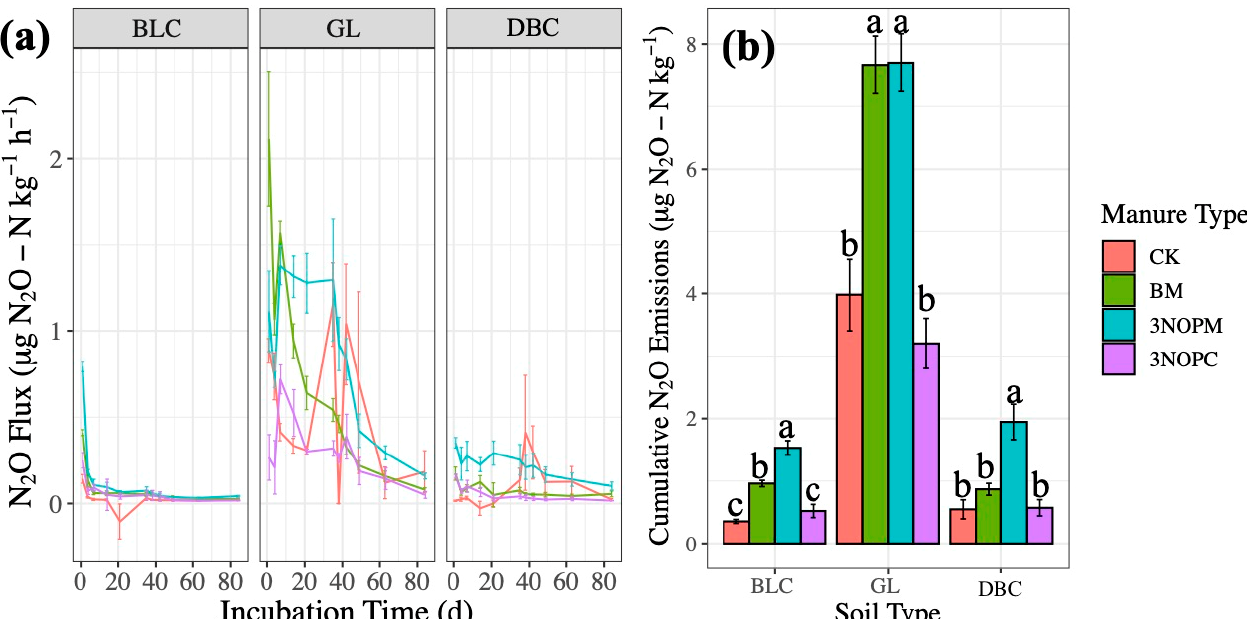
Figure 2. Effects of manure type on N 2 O emissions ( a ) over time by soil type and ( b ) cumulatively by soil type in a laboratory incubation experiment. Soil type: BLC, Black Chernozem; GL, Gray Luvisol; DBC, Dark Brown Chernozem. Manure type: CK, control with no amendments; BM, barley ‐ based manure; 3 ‐ NOPM, manure from cows fed 3 ‐ NOP supplement; 3 ‐ NOPC, composted manure from cows fed 3 ‐ NOP supplements. Treatments that do not share the same letter are significantly different from each other. Error bars indicate standard errors of the means ( n = 4).